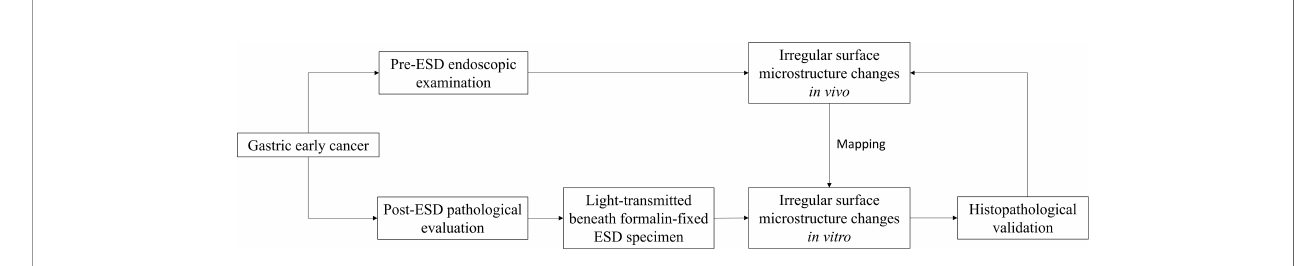
FIGURE 1 | Scheme of the match comparison between the endoscopic and histopathological